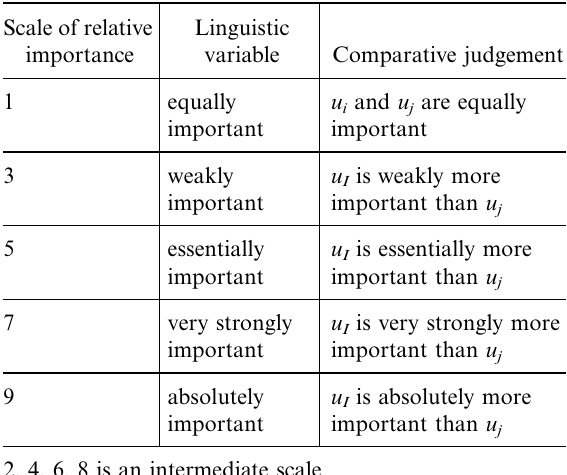
Table 1. Comparison of relative importance of